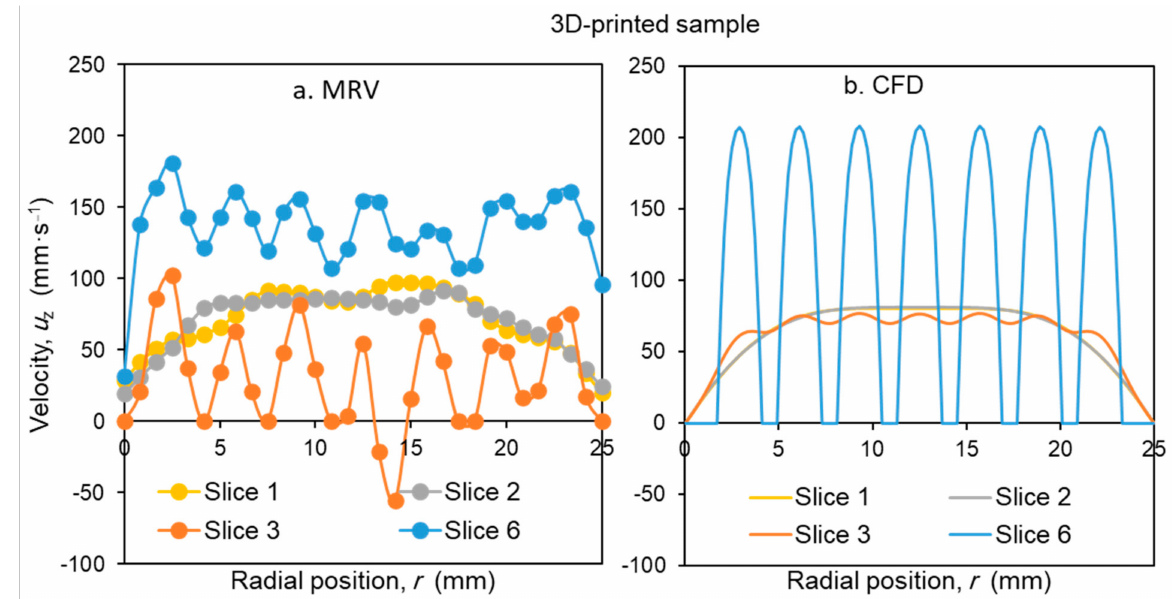
Figure 11. The velocity profile of u z over an arbitrary line (Figure 10) across the radius of the monolith determined by MRV ( a ) and CFD ( b ). Slices 1 to 3 and 6 correspond to the sample slice numbers given in Figures 6 and 9. The yellow and gray curves show the bulk flow approaching the honeycomb. The orange curves show the flow at the interface of the flow and solid structure, where the contraction takes place. The blue curves represent the velocity profile in the monolith